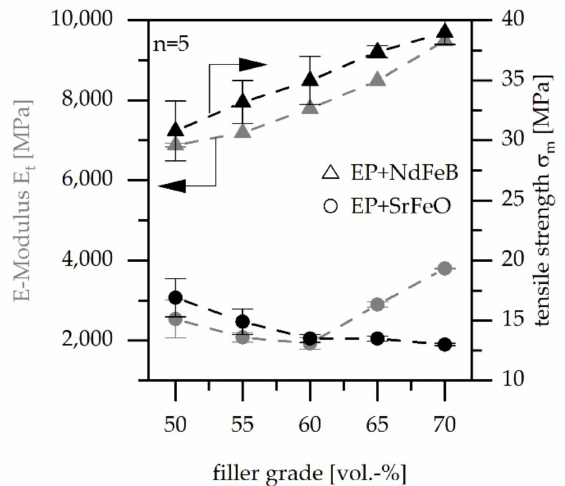
Figure 10. Mechanical properties of EP-based compounds relative to different fillers and filler grades (SrFeO: strontium-ferrite-oxide; NdFeB: neodymium-iron-boron; EP: epoxy resin).